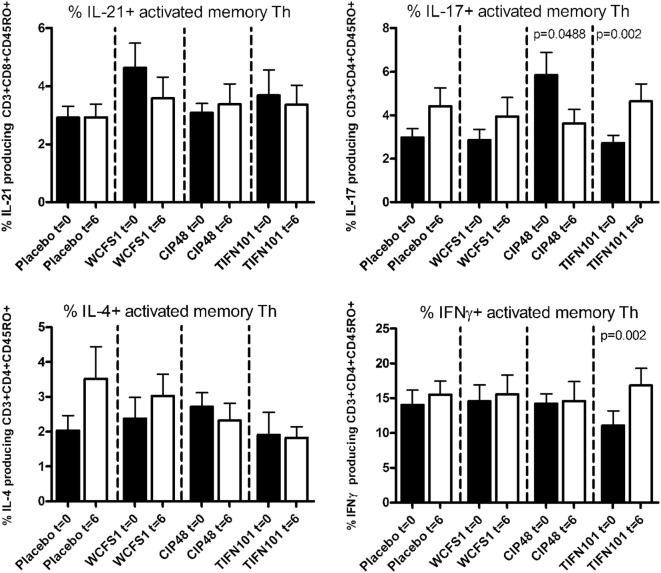
Effects of three Lactobacillus plantarum strains on the frequency of IL-21, IL-17, IL-4, and IFN-γ-producing Staphylococcus aureus enterotoxin B superantigen (SEB)-stimulated memory-CD45RO+ Th cells. Data are expressed as mean ± SEM. Statistical significant differences were determined by using two-sided Student’s t-tests. A p-value <0.05 was considered statistically significant. A p-value <0.1 was considered a statistical trend.